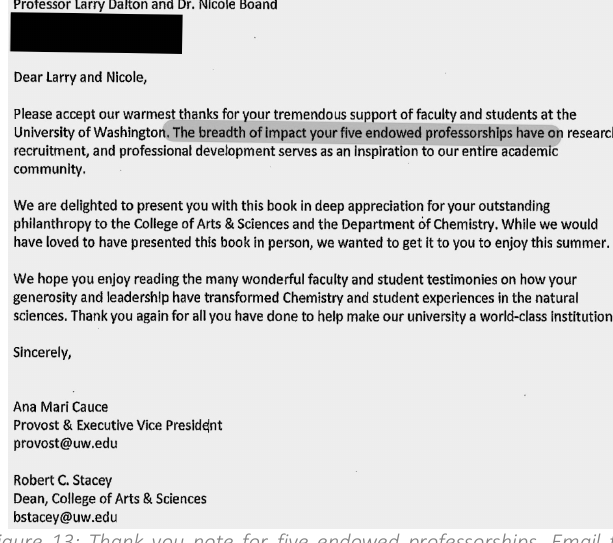
Figure 13: Thank you note for five endowed professorships. Email from Provost Cauce and Dean Stacey to LD and his wife, Nicole Boand, 2013, Aug